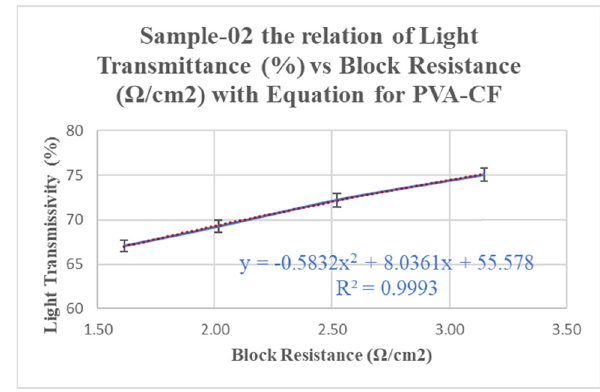
Figure 22: Sample - 02 ( CF:PVA = 0.2:30 ) Light Transmittance ( % ) versus block resistance ( Ω ) with equation for PVA - CF. The dotted lines represent the polynomial fi tted curve and the linear fi tted line.